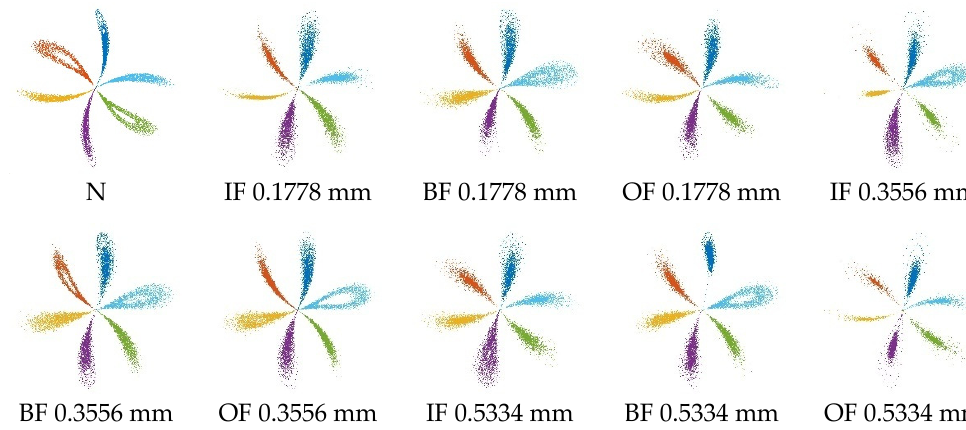
Figure 11. M-SDP images of 10 bearing states.